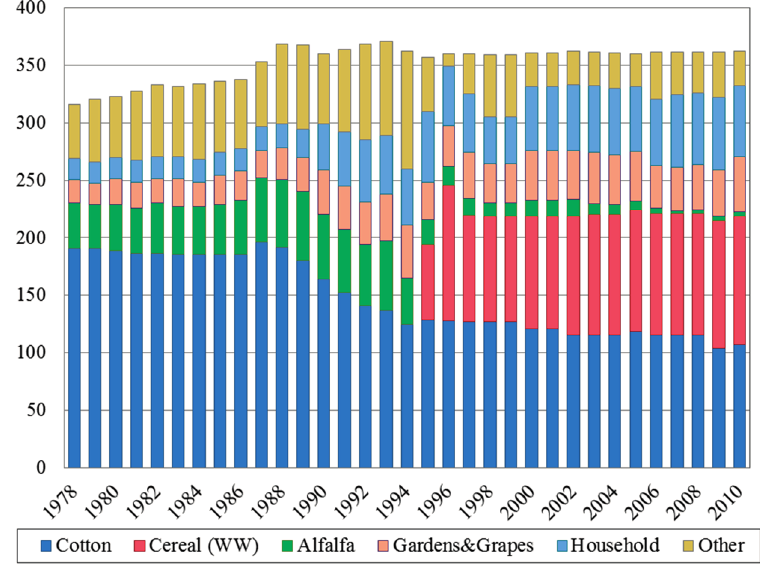
Figure 6. Changes of cropping patters 1978 to 2010 (1,000